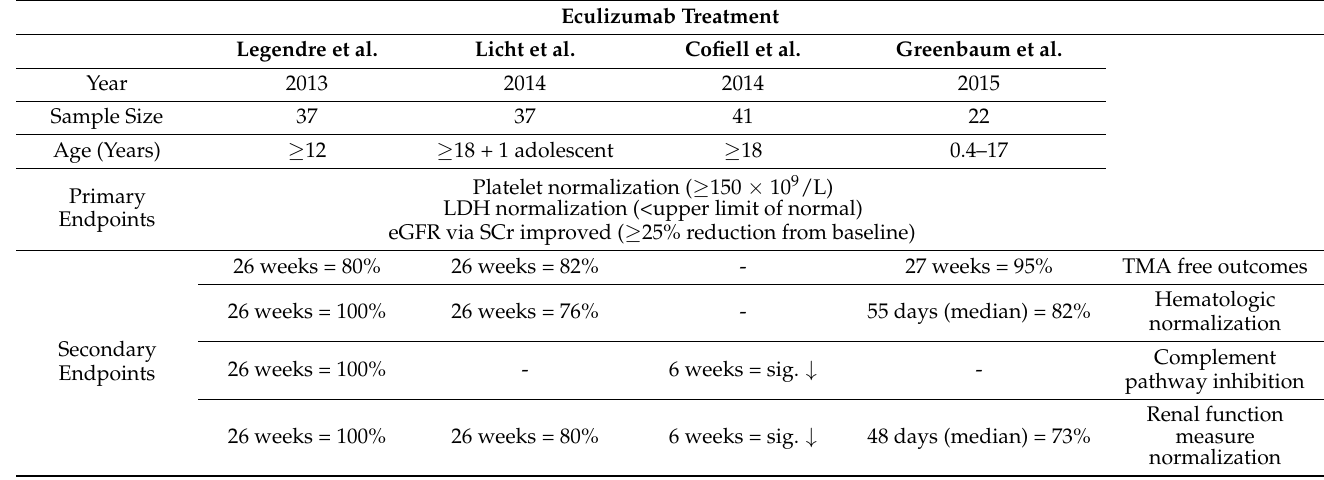
Renal function measure